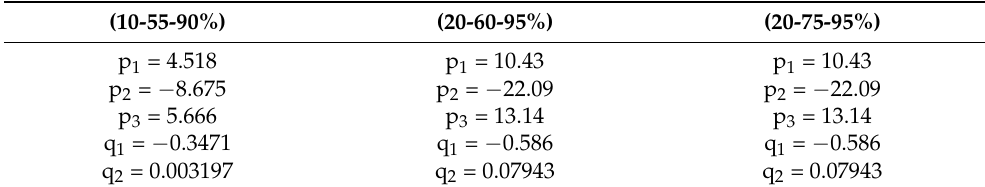
Table 9. Parameters {p i , q i } of the rational function f 3 ( α ) for the different sets of asymmetrical points. Note that the parameters for (20-60-95%) and (20-75-95%) are the same since their x 3 -values are the same (x 3 =